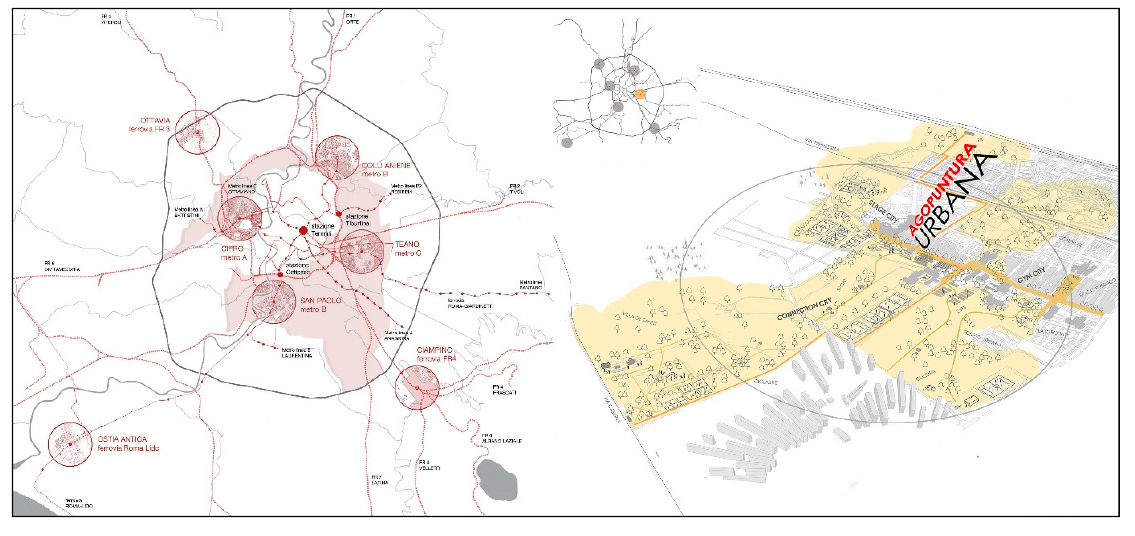
Figure 5. Left : planimetry with identification of the nodes at the metro station; in red the green belt within which there is urban traffic restriction; right : Node Teano urban acupuncture (Source: Authors)